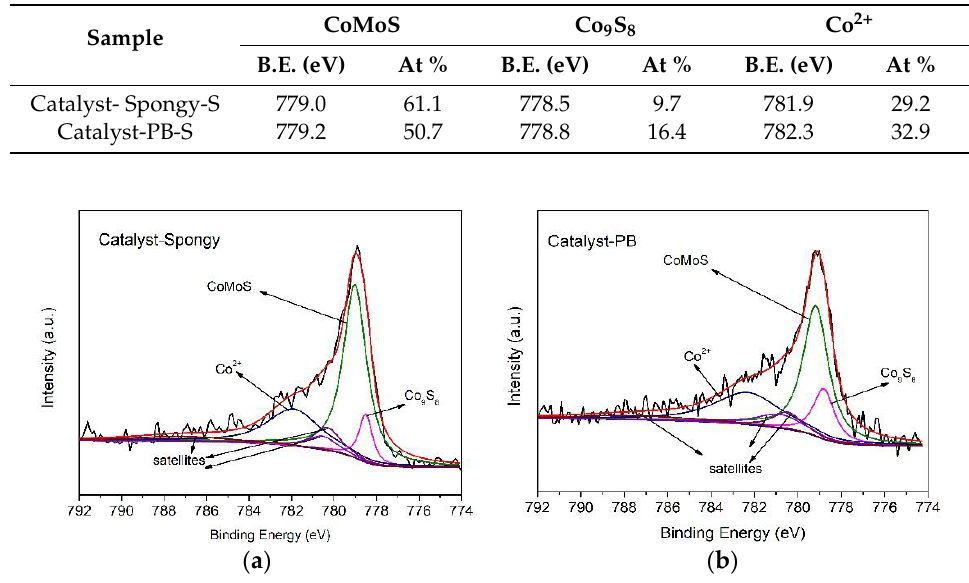
Figure 8. The measured and curve-fitted Co2p XPS spectra of ( a ) Catalyst-Spongy-S and ( b ) Catalyst-PB-S.